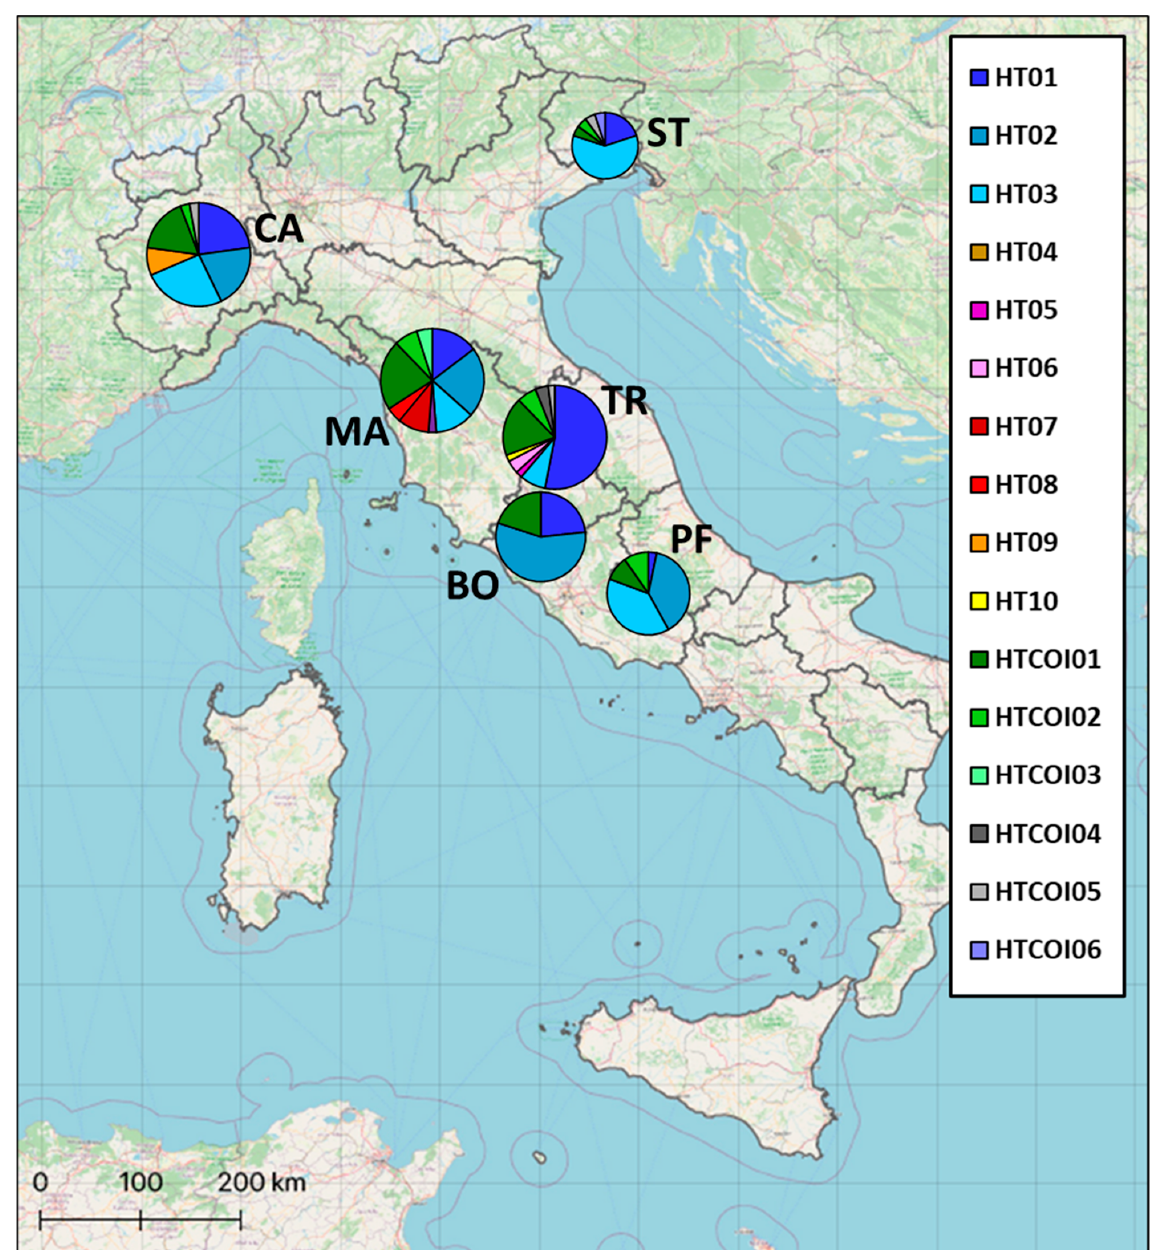
Figure 3. Sampling locations and frequency distribution of mtDNA haplotypes from 153 control- region and 53 COI sequences belonging to six Italian P. clarkii populations. Basin codes as in Table 1.